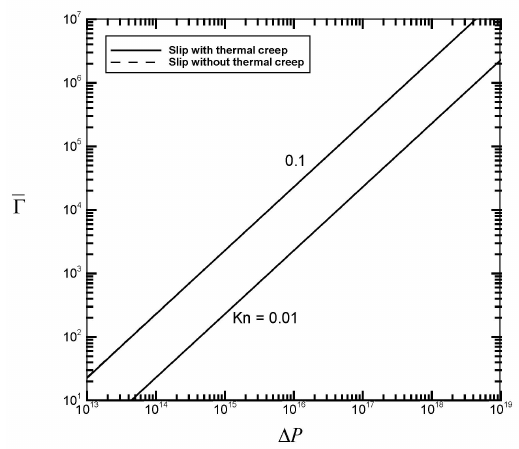
Figure 3. Flow rate M  versus the dimensionless pressure drop Δ P for different values of Kn with GrL = 10 2 and Ec = 10 −20 .